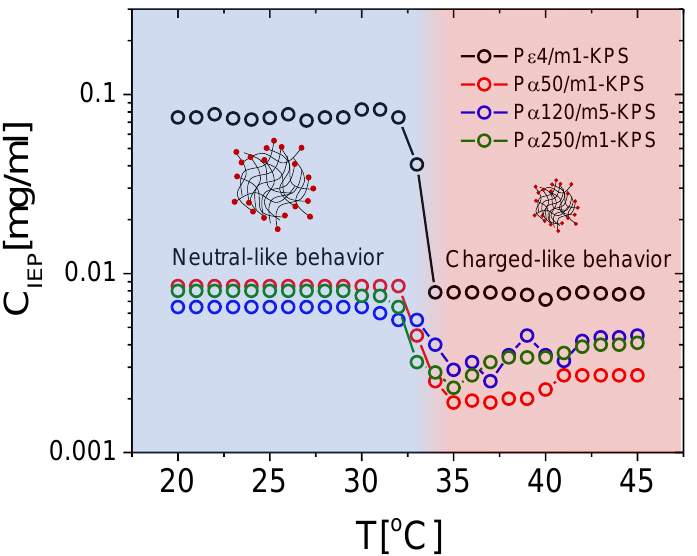
Figure 6. C IEP in function of temperature for all the investigated PLL-microgel mixtures. The sudden drop of C IEP in proximity of T c marks the electrokinetic transition between the neutral-like and the charged-like state of PNIPAm